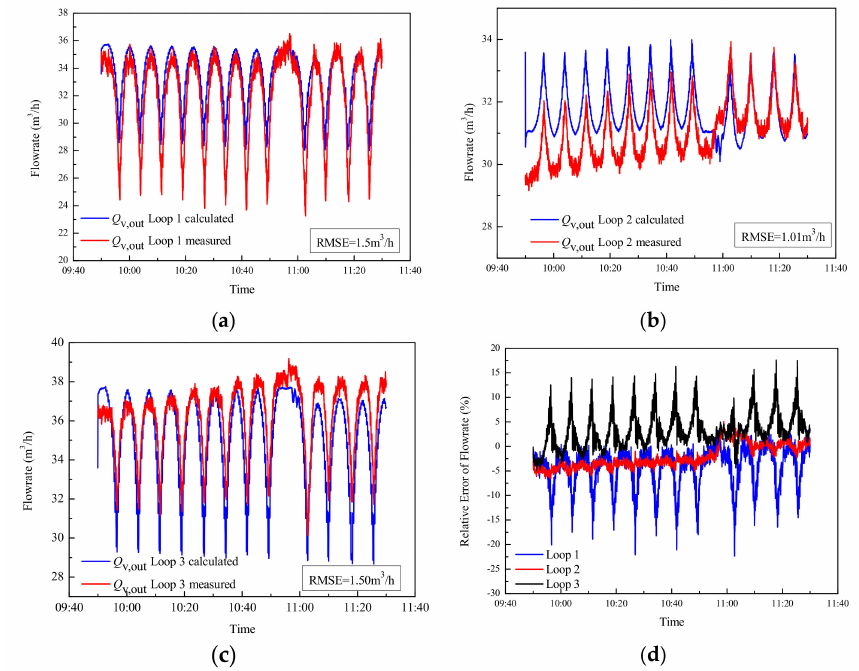
Figure 14. Compared results between calculated and measured data in a hot test for ( a – c ): the outlet flow rate of loops 1 to 3; and ( d ) the relative errors of the flow